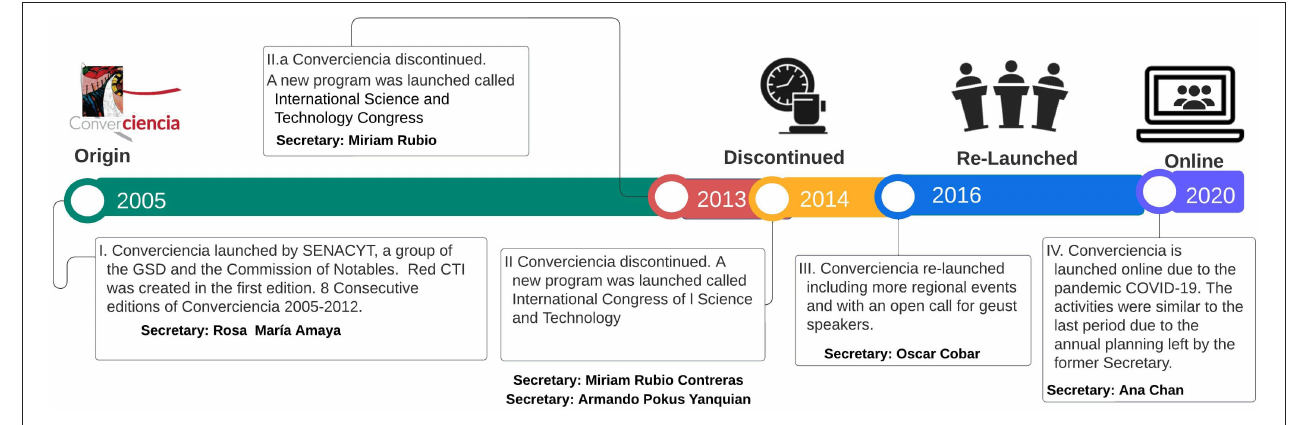
FIGURE 2 | Timeline: Converciencia (2005–2020). Source: own elaboration.